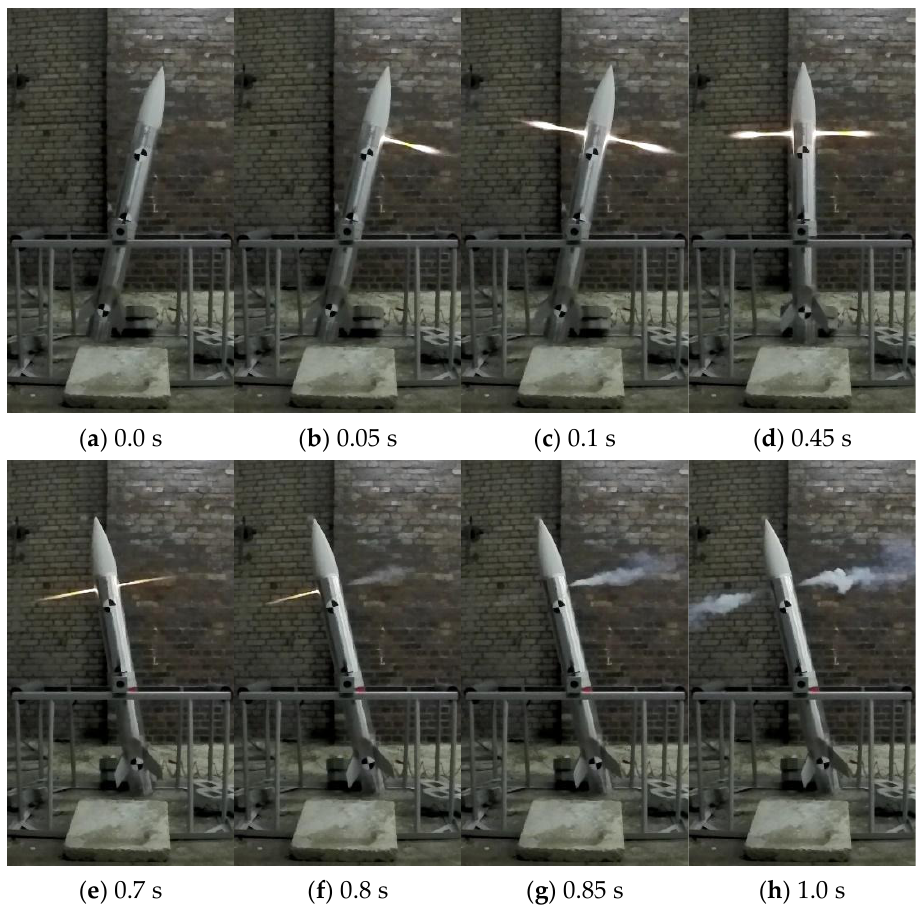
Figure 19. Ground tests of the lateral thrusters (test 1).